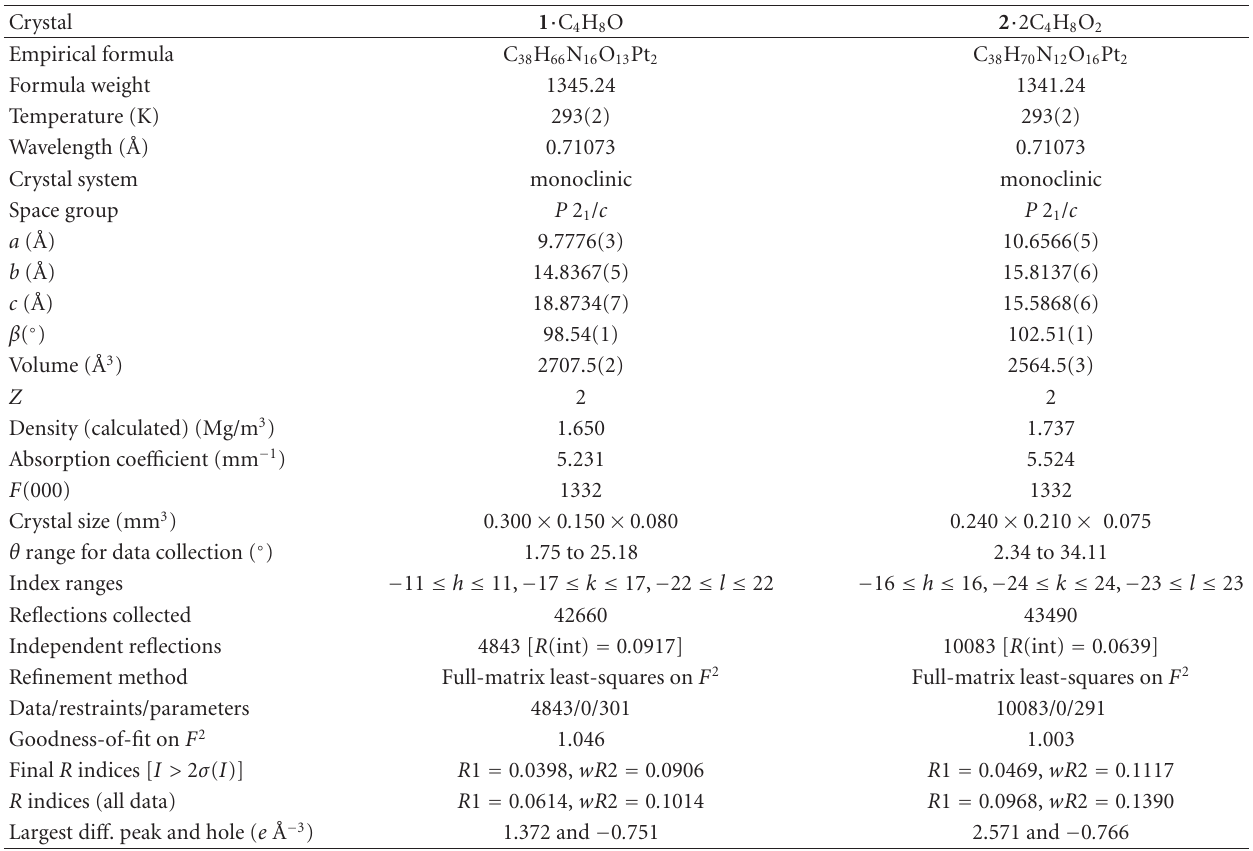
Table 1: Crystal data and structure refinement parameters for [Pt 2 { HN = C(Bu t )O } 4 (9-EtG) 2 ](NO 3 ) 2 · tetrahydrofurane ( 1 · C 4 H 8 O)